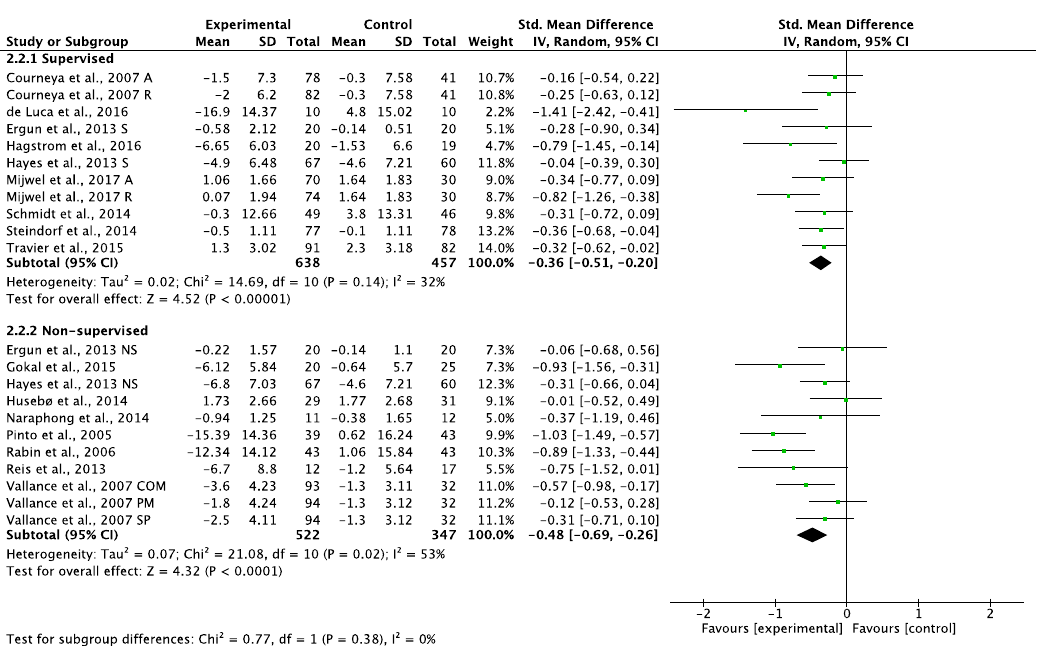
Figure 6. Meta-analyses of the effects of supervised [46,48–50,52,53,58,59,64] and non-supervised Figure 6. [38,40,42,49,57,59,60,62,65] exercise interventions of more than 12 weeks on CRF in BC patients. A: aerobic exercise group; COM: combination of printed materials and step pedometer; NS: non-